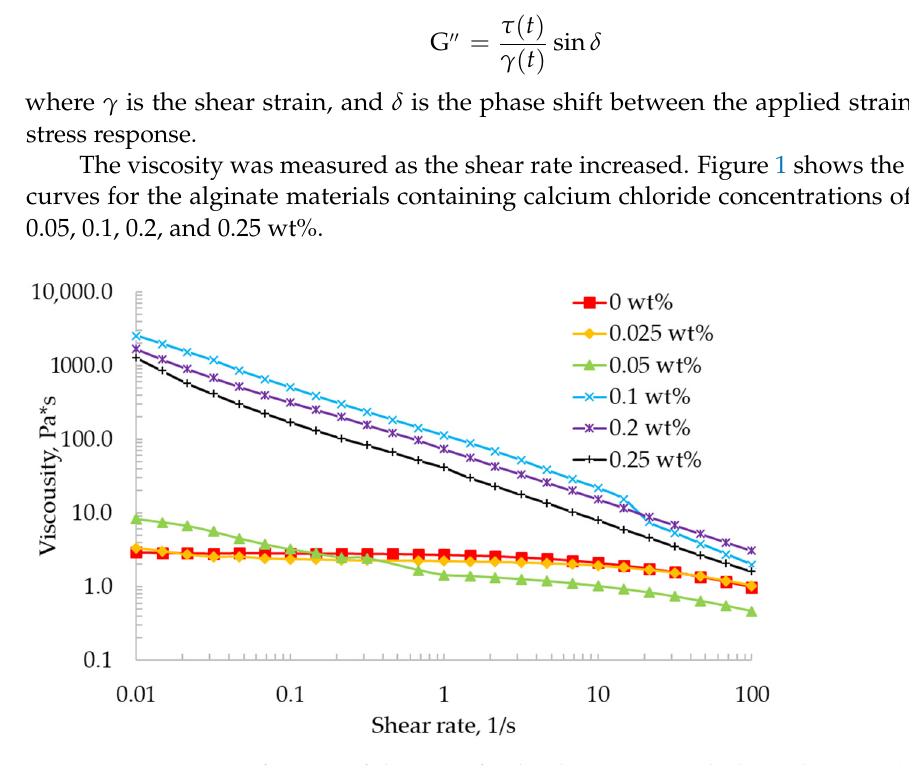
Figure 1. Viscosity as a function of shear rate for the alginate materials (logarithmic axes). From the presented graphs, it can be seen that the viscosity of alginate materials with a crosslinking agent concentration of 0 and 0.025 wt% decreases slightly with an increase in the shear rate; in this case, at a shear rate of up to 10 s − 1 , the effect of the shear orientation is small. These materials exhibit behavior similar to Newtonian